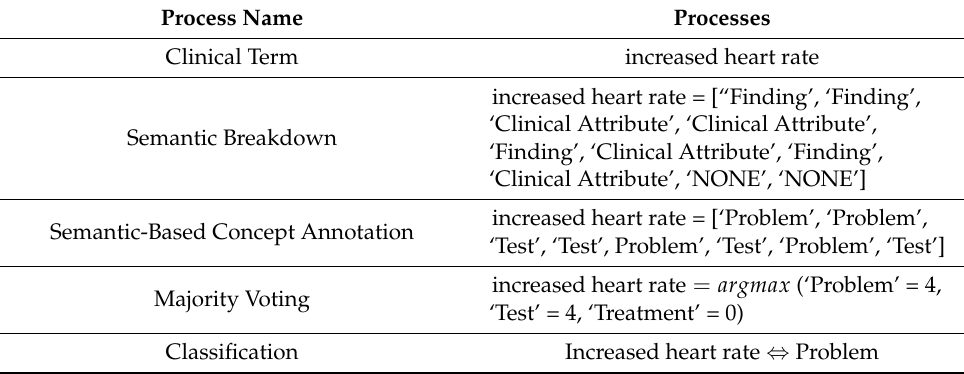
Table 4. Present the implementation scenario of Rule